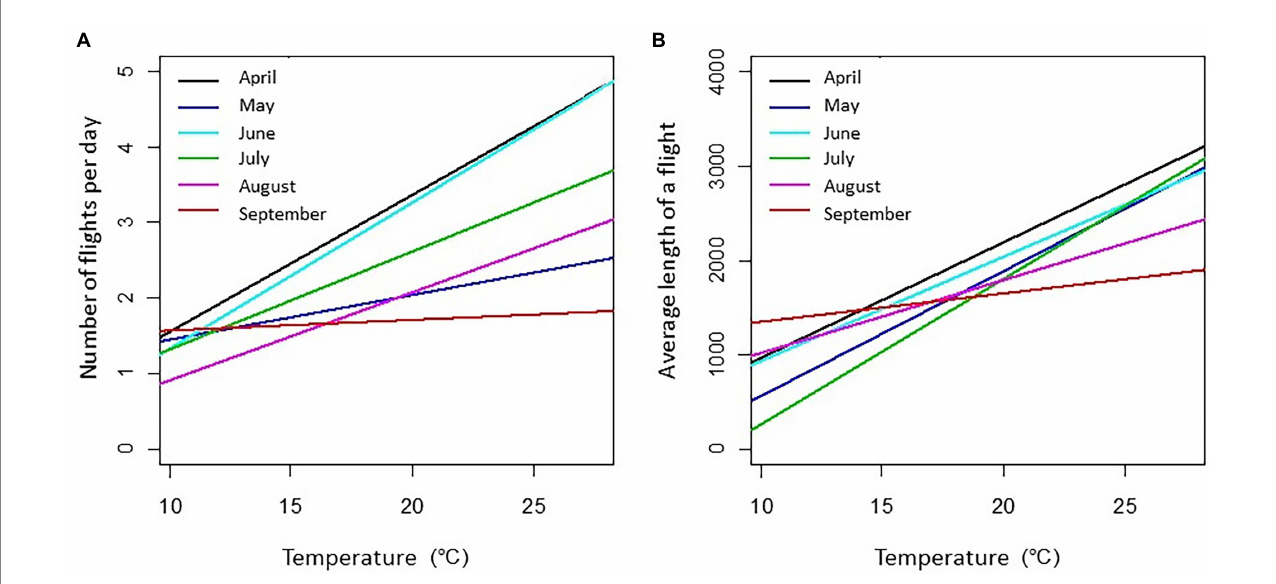
FIGURE 2 Mathematical model that predicts the number of honey bee exits from the hive according to ambient temperature. The curves depict the results of linear models, all significant, established based on recordings of RFID transponder-labelled workers ( n = 1,330 bees in total; Requier, 2013). (A) Number of exits by bee and by day. (B) Average duration of trips by bee and by day in second. The amplitude of daily temperatures recorded in April, May, June, July, August, and September were, respectively, 10.2–20.7, 12.9–27.6, 13.7–27.6, 15.1–26.1, 13.3–26.1, and 12.0–22.3 ° C. The number of recorded bees per month ranged from 90 to 308.